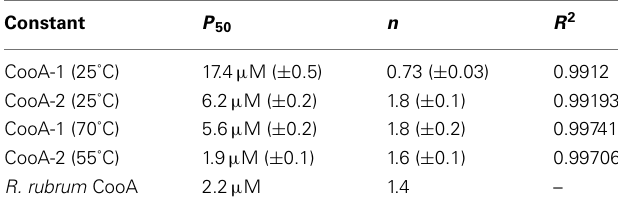
Table 3 | Disassociation constants and cooperativity data for CO-binding to CooA-1 or CooA-2 as determined from fitting the changes in fractional saturation to the Hill